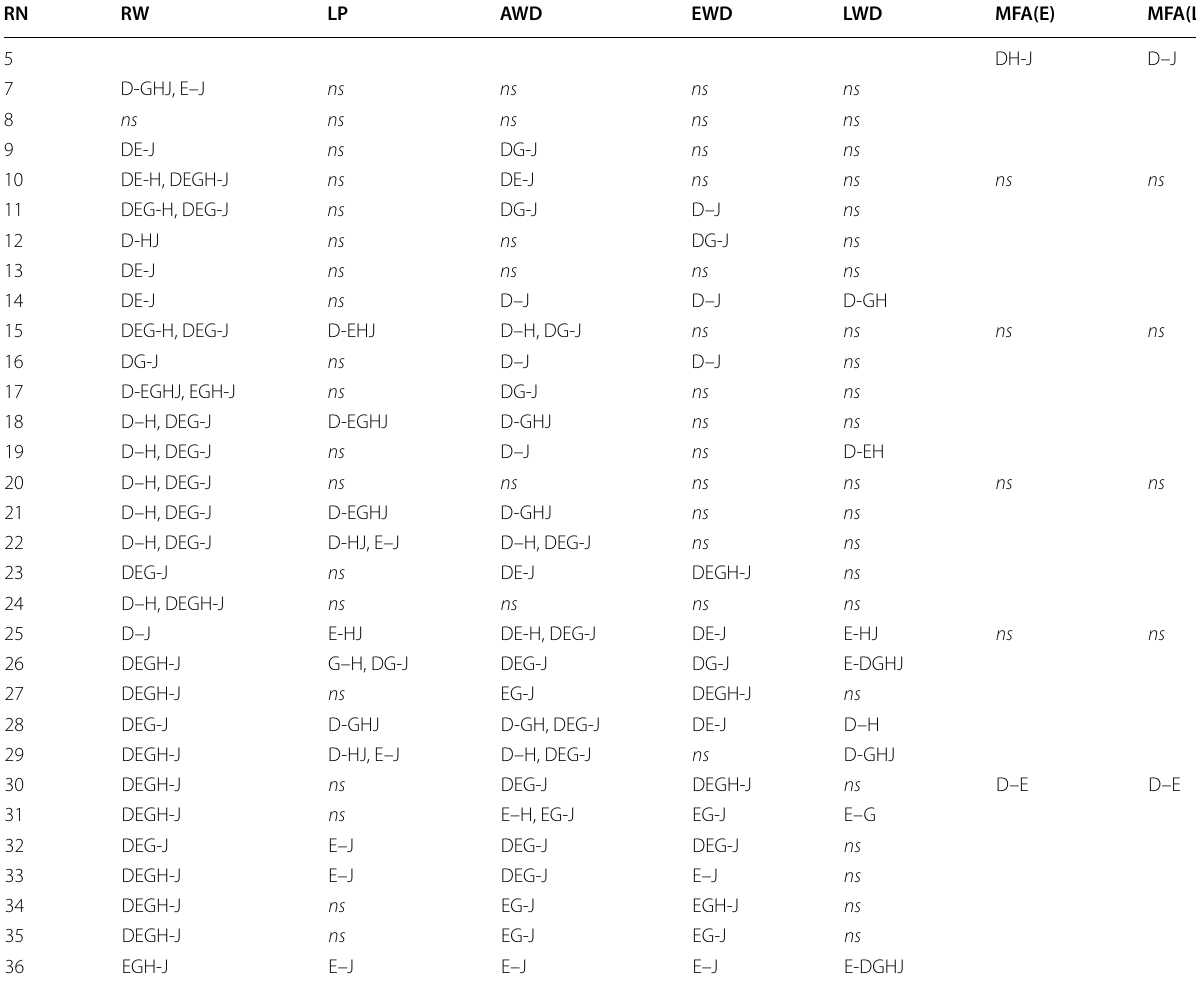
Significant difference of anatomical wood properties among initial tree density zoning symbols were examined (Tukey HSD) ns no significant difference ( p 0.05), DE-J in the row of RW means that ring width in J trees were significantly different from those in D tress and E trees ( p < 0.05). ≥ RN ring number, RW ring width, LP latewood percentage, AWD average wood density, EWD earlywood density, LWD latewood density, MFA(E) MFA of earlywood tracheids, MFA(L) MFA of latewood